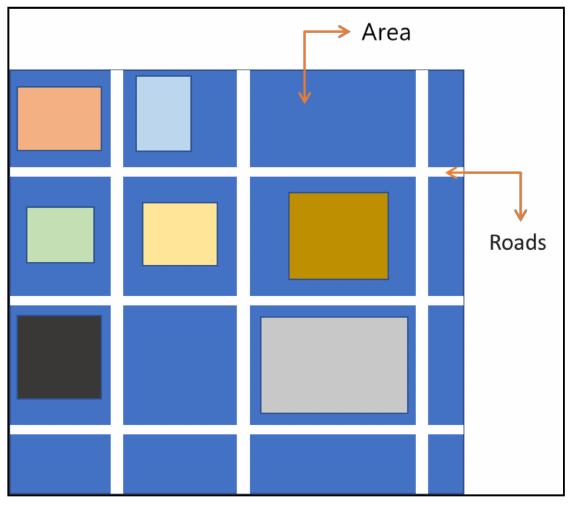
Figure 2. Areas separated by